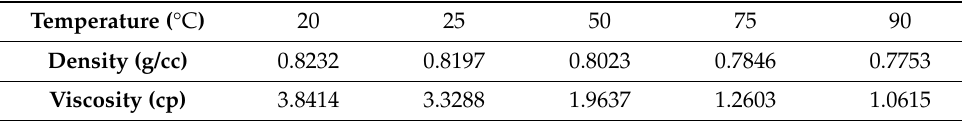
Table 1. The density and viscosity of the oil at each